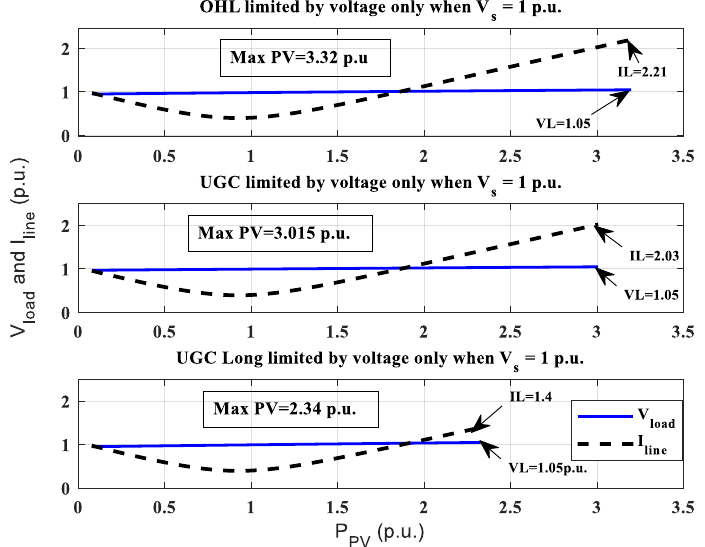
Energies 2021 , 14 , x FOR PEER REVIEW 12 of 23